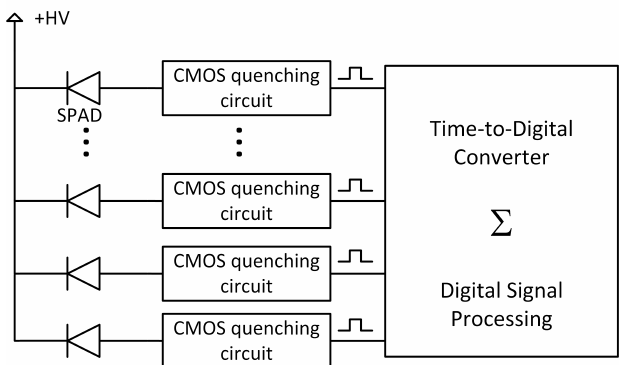
Figure 2. Schematic of a PDC. A CMOS microelectronic circuit is used to quench 1-to-1 a given